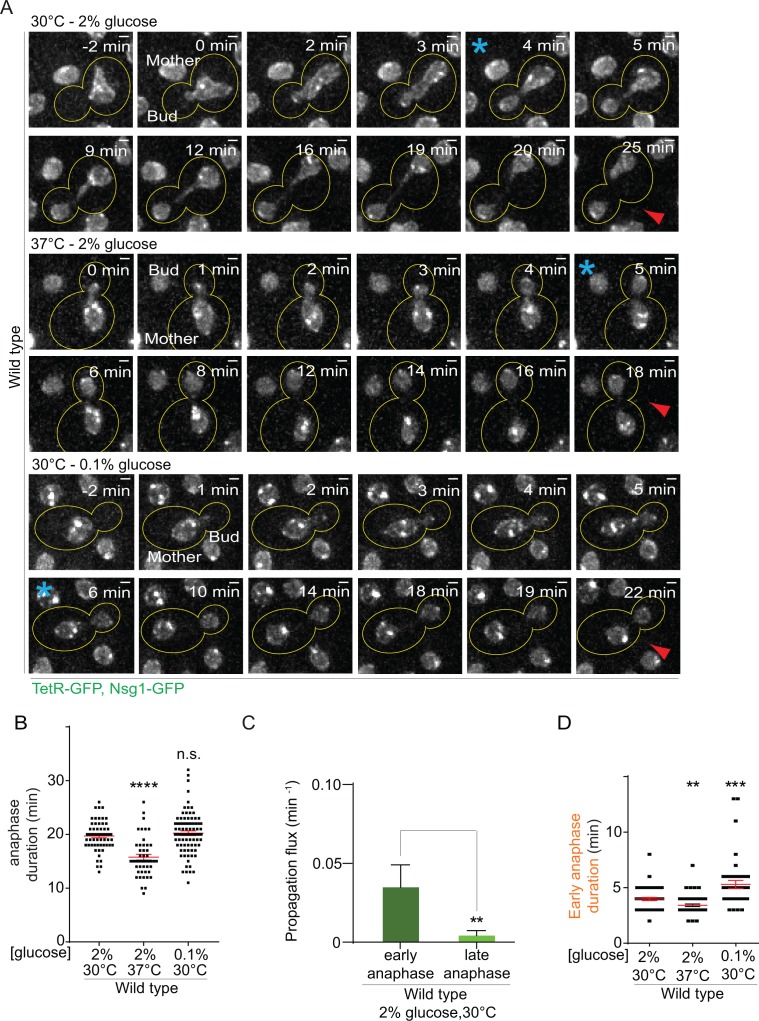
Changes in anaphase duration cannot explain DNA circle segregation upon heat stress.(A) Dividing nuclei used to measure the duration of anaphase (maximum intensity projection, outline of the cell in yellow, scale bar is 1 µm). Bright dots represent either DNA circles or, if at the opposite sides of the nucleus, the SPBs. For the purpose of the analysis presented here, we measured only the timing of nuclear division without looking at the behavior of the DNA circles. 0 min was set as the beginning of anaphase. The red arrow marks karyokinesis, whereas the blue asterisks mark the end of early anaphase (see Figure 2—figure supplement 1). B) Quantification of anaphase duration (mean ±SEM of three to four independent experiments with 47 < n < 83 cells and two or three independent clones per condition). Non-parametric Mann-Whitney U test: ****p<0.0001. (C) The propagation flux of individual DNA circles through the bud neck (mean ± SD passage frequency per minute in early and late anaphase of four independent experiments and three independent clones). Number of cells is 51 ≤ n ≤ 104 cells per anaphase stage; Unpaired t-test, **p<0.01. (D) Quantification of early anaphase duration (mean ±SEM of two to three independent experiments per condition), 47 ≤ n ≤ 53 cells per condition. Non-parametric Mann-Whitney U test: **p<0.01.